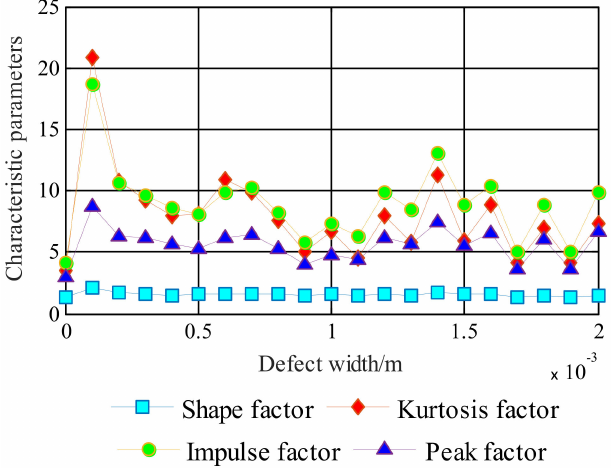
Figure 23. Influence of defect width on dimensionless CP.